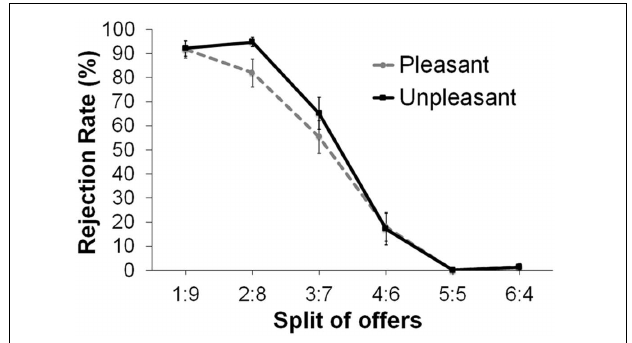
FIGURE 3 | Rejection rates as a function of offer split across the two groups.